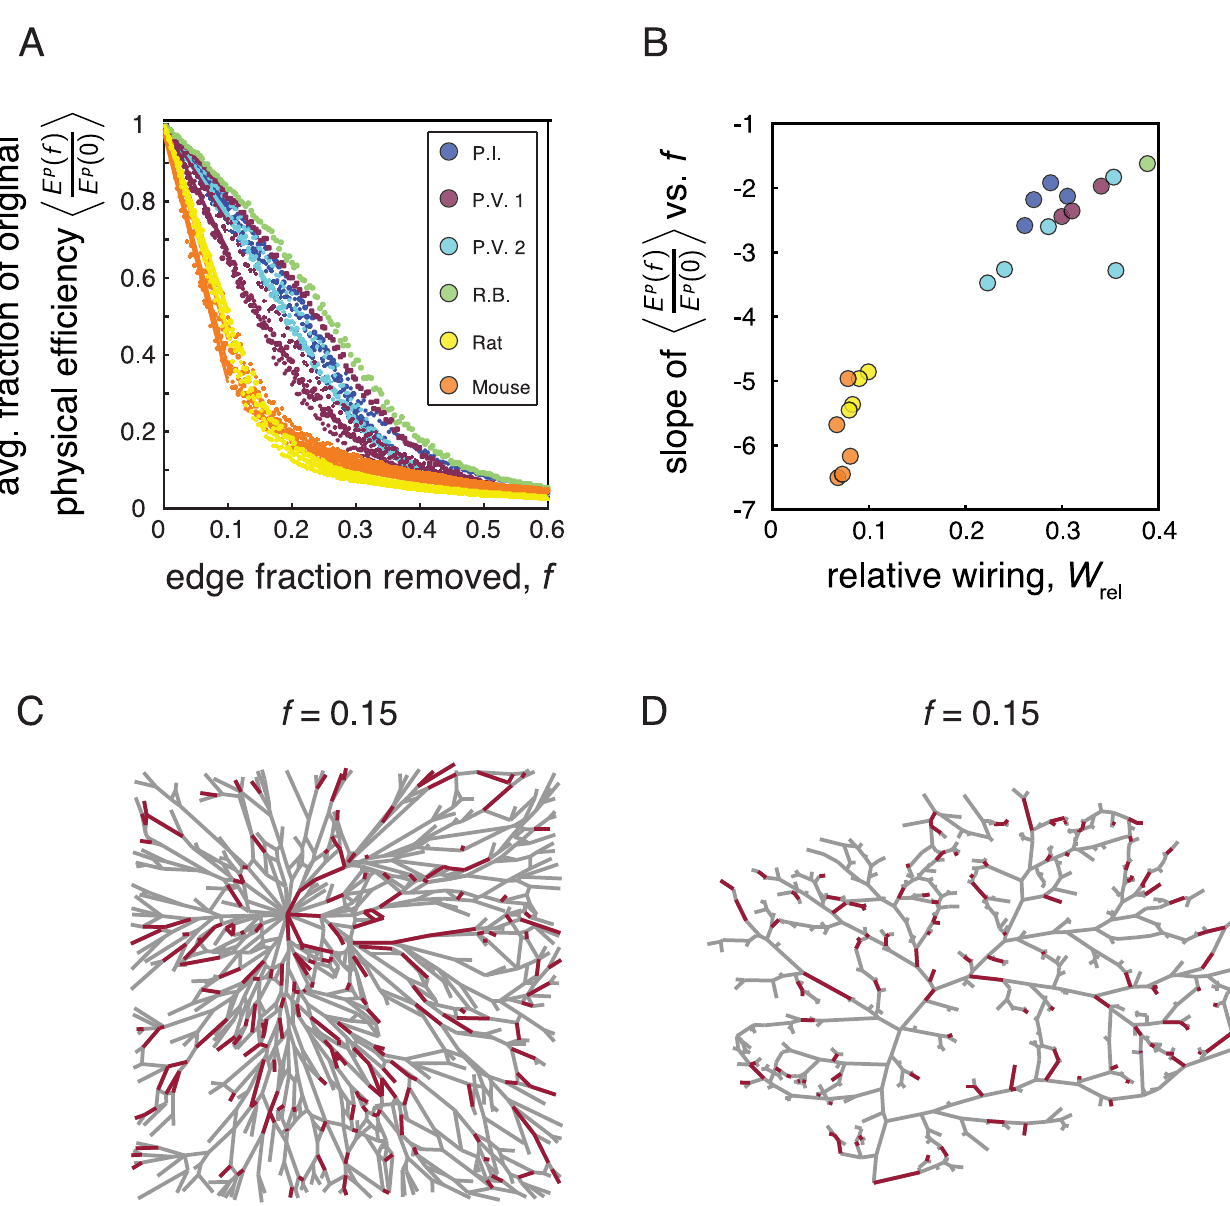
Fig 8. Decline of physical efficiency with random edge removal. (A) Ensemble average of the ratio of the physical efficiency of damaged networks to the physical efficiency of the original network, as a function of the edge fraction removed. The efficiency of the vasculature networks declined more rapidly than that of the fungal networks. (B) The drop-off in physical efficiency was approximated for each network as the slope of a linear fit to E p ( f )/ E p (0) vs. f , computed between f = 0 and f = 0.1. There was a positive correlation between the slope and the relative wiring of the networks. (C) An example of a network from P.V. 2 , where the red lines correspond to a random selection of f = 0.15 of the total number of edges, and the gray lines correspond to the remaining edges in the network. (D) An example of a network of a mouse vasculature system, where the red lines correspond to a random selection of f = 0.15 of the total number of edges, and the gray lines correspond to the remaining edges in the